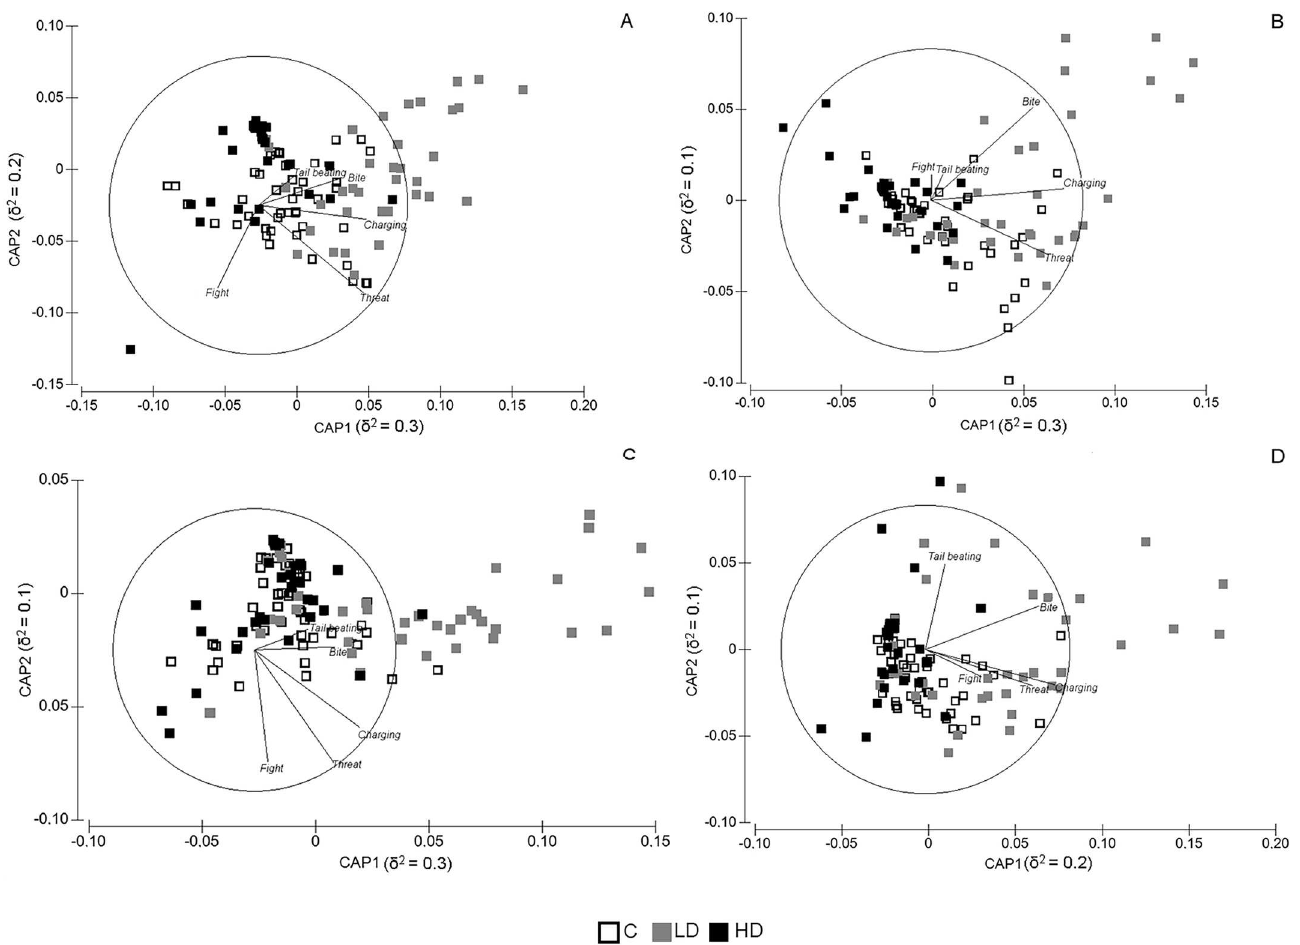
Fig 1. Canonical analysis of principal coordinates for the factor treatment. CAP ordination was obtainedfrom the distancematrix among specimenson the basis of behavioural responses measuredas Duration(A, B before and after feeding)and Frequency (C, D before and after feeding, respectively). Vectors represents the Pearson correlationof variablesto axes (CAP 1 or CAP 2). The length of the vector is proportional to the strength of correlation.